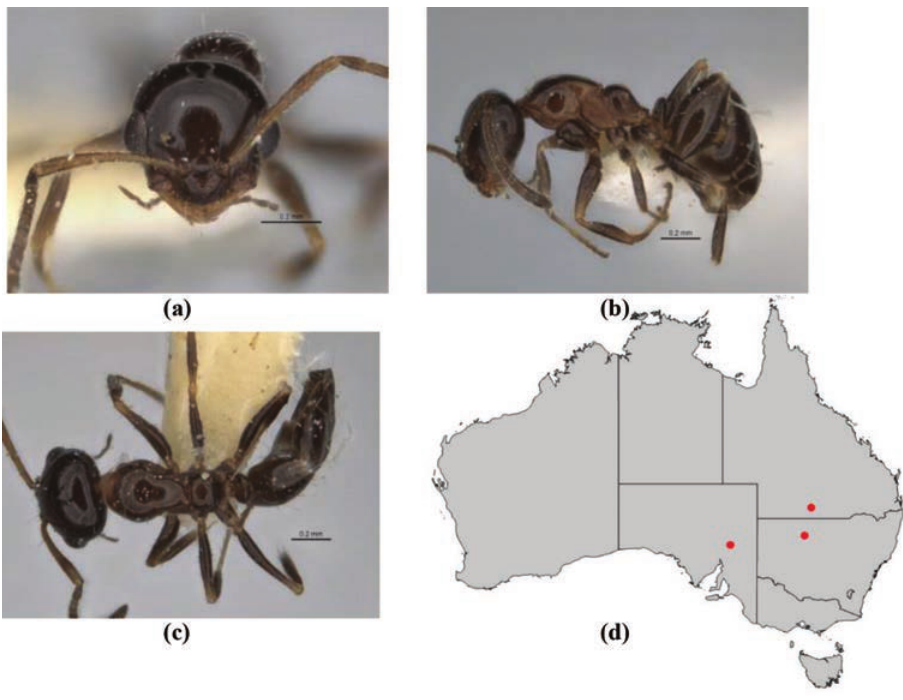
Figure 41. Melophorus macrops sp. n.: minor worker holotype (ANIC32-900105) frons ( a ), profile ( b ) and dorsum ( c ); distribution map for the species ( d ). Low resolution scale bars: 0.2 mm ( a–c ).